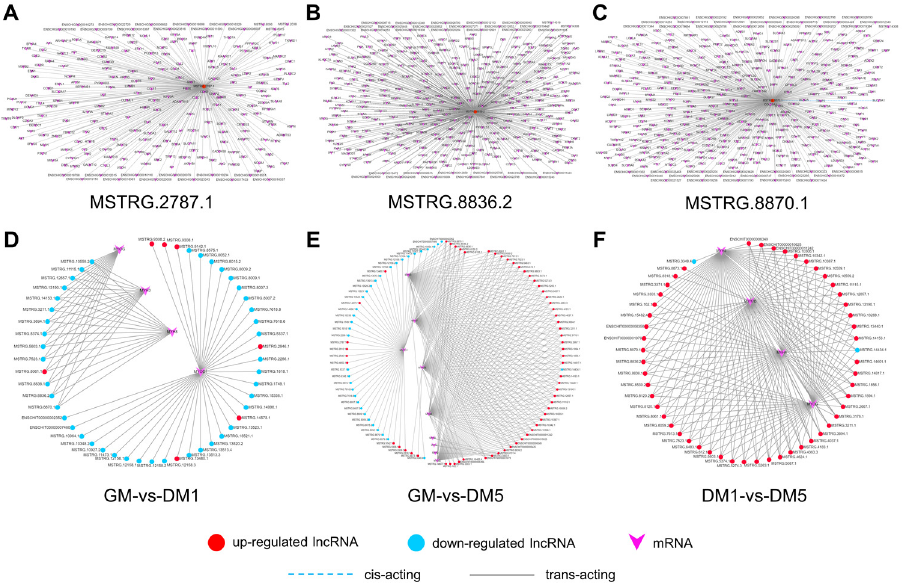
Figure 6. The lncRNA-mRNA interaction networks. ( A – C ) LncRNA-mRNA networks for MSTRG.2787.1, MSTRG.8836.2, and MSTRG.8870.1. ( D – F ) LncRNA-mRNA networks associated with MyoD, MyoG, and MyHC in GM-vs-DM1, GM-vs-DM5, and DM1-vs-DM5. DE lncRNAs and their corresponding target genes were used to establish the lncRNA-gene interaction networks. In these networks, genes are displayed in purple arrow, while lncRNAs are displayed in circle; up-regulated lncRNA is indicated with red, while down-regulated lncRNA is indicated with blue. The cis-acting interactions are represented as dashed lines, whereas the trans-acting interactions are represented as solid lines.